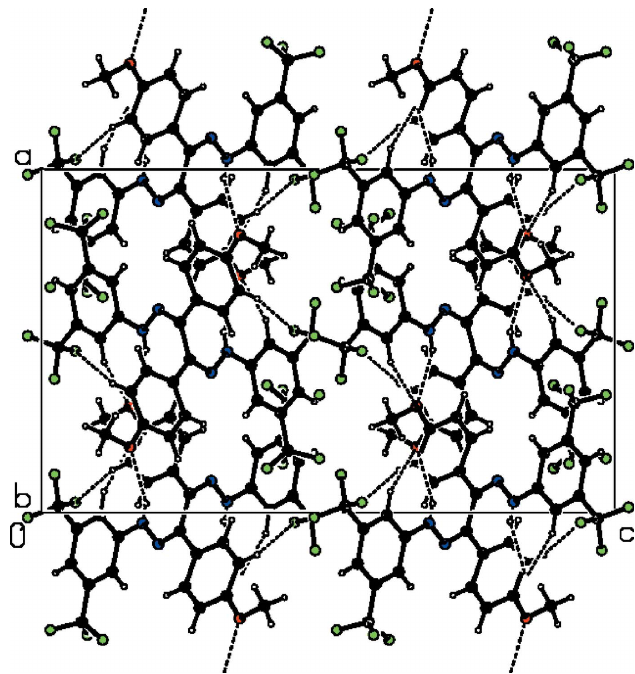
Figure 2 Crystal structure of the title compound viewed along the b axis. Dashed lines show hydrogen-bonding interactions. The minor components of the disordered CF 3 group have been omitted.